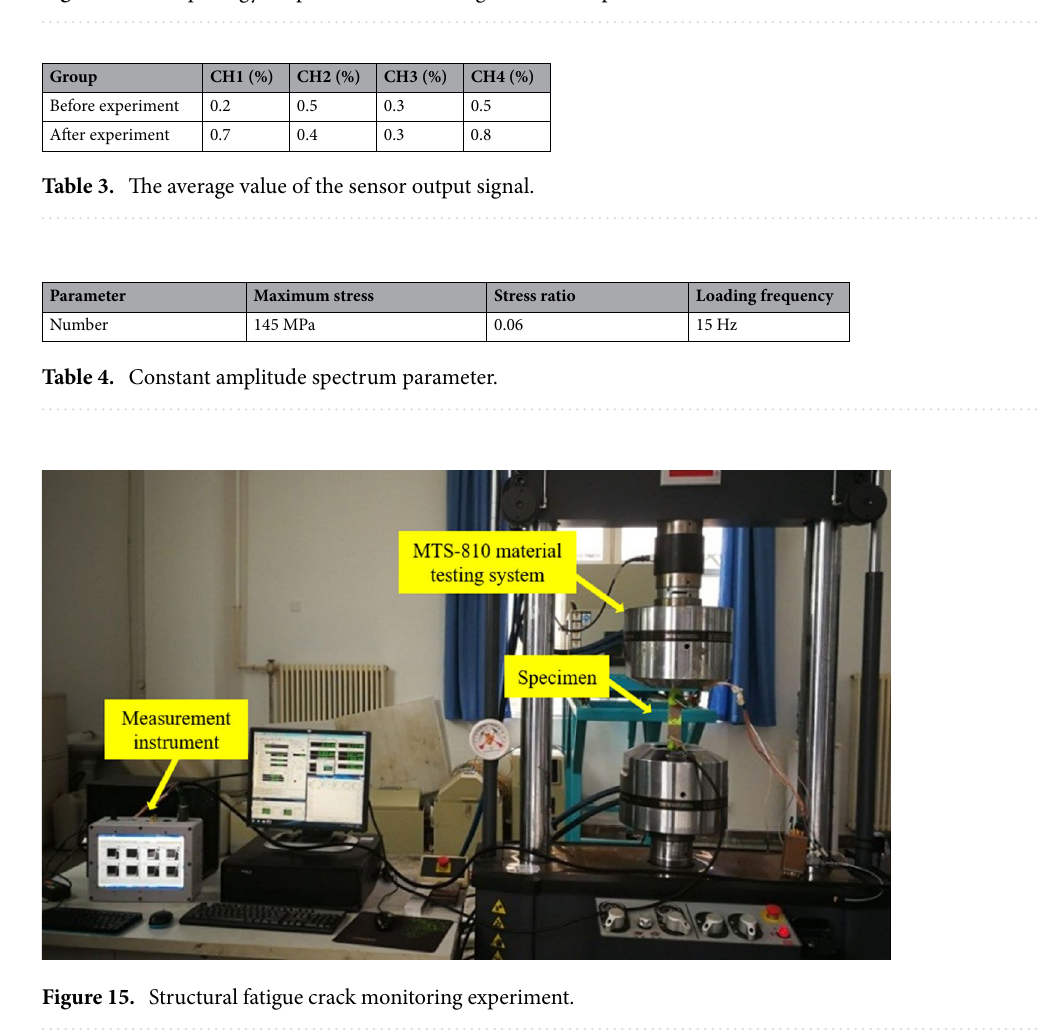
Figure 14. Morphology of specimen after salt fog corrosion experiment.